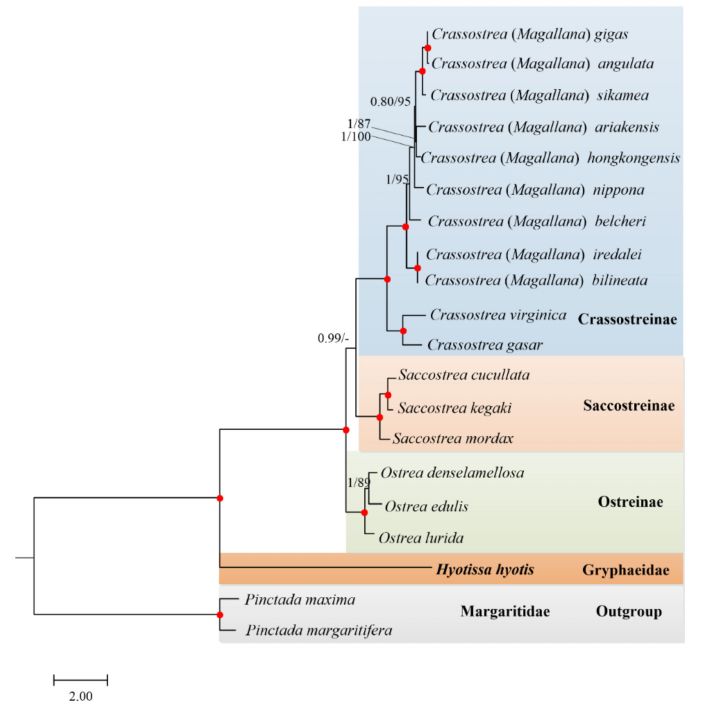
Figure 6. Phylogenetic relationships of Ostreoidea based on the concatenated nucleotide sequences of 12 mitochondrial protein-coding genes. The reconstructed Bayesian inference (BI) phylogram using Pinctada margaritifera and P. maxima as outgroup is shown. The first number at each node is Bayesian posterior probability (PP), and the second number is bootstrap proportion (BP) of maximum likelihood (ML) analyses. Nodal with maximum statistical supports (PP = 1; BP = 100) is marked with a solid red circle. BP values under 80 are marked as dash